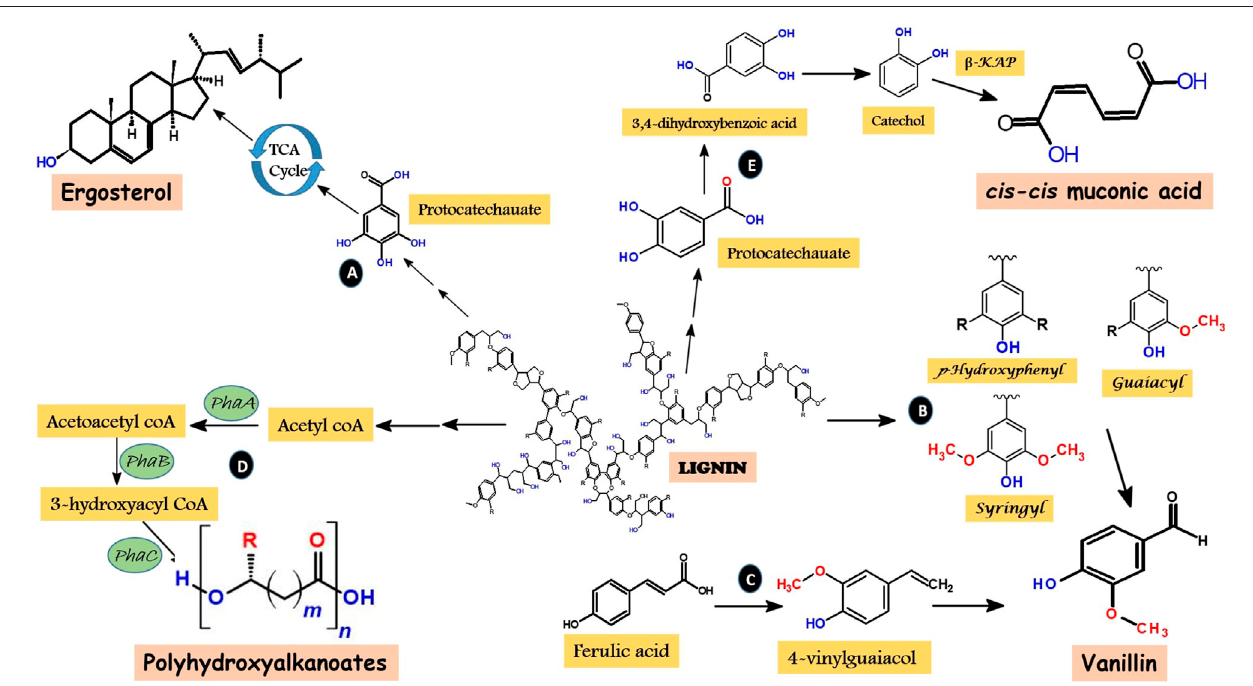
FIGURE6| Overviewofvariouspathwaysinvolvedinselectivedegradationofligninintodesiredvaluableproducts. (A) Keyroutetosynthesizemicrobiallipids,with ergosterolas anexamplevia TCA cycle. (B) Vannilin biosynthesis through lignindegradation to monomeric units. (C) Vannilin biosynthesisthrough degradation offerulic acid. (D) Highlights of the multiple pathways in formation of polyhydroxyalkanoates where acetyl CoA acts as the main player. (E) Key reactions involved in cis-cis muconic acid formation. Where TCA, Tricarboxylic acid; β -KAP, β -ketoadipate